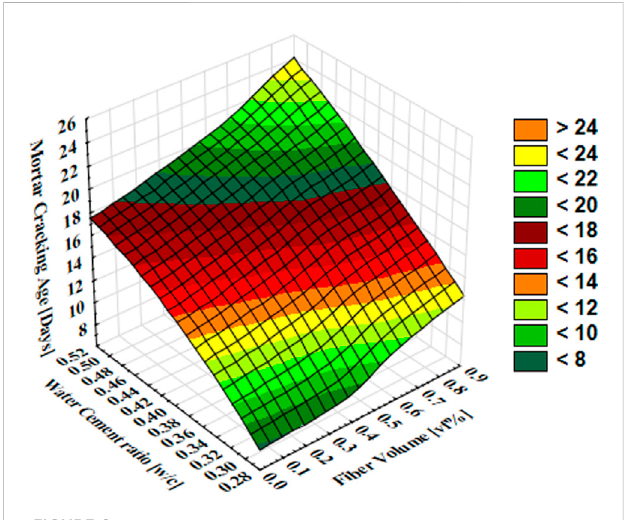
FIGURE 8 Mortar-cracking age (days) against fi bre V f (%) and w/c ratio.